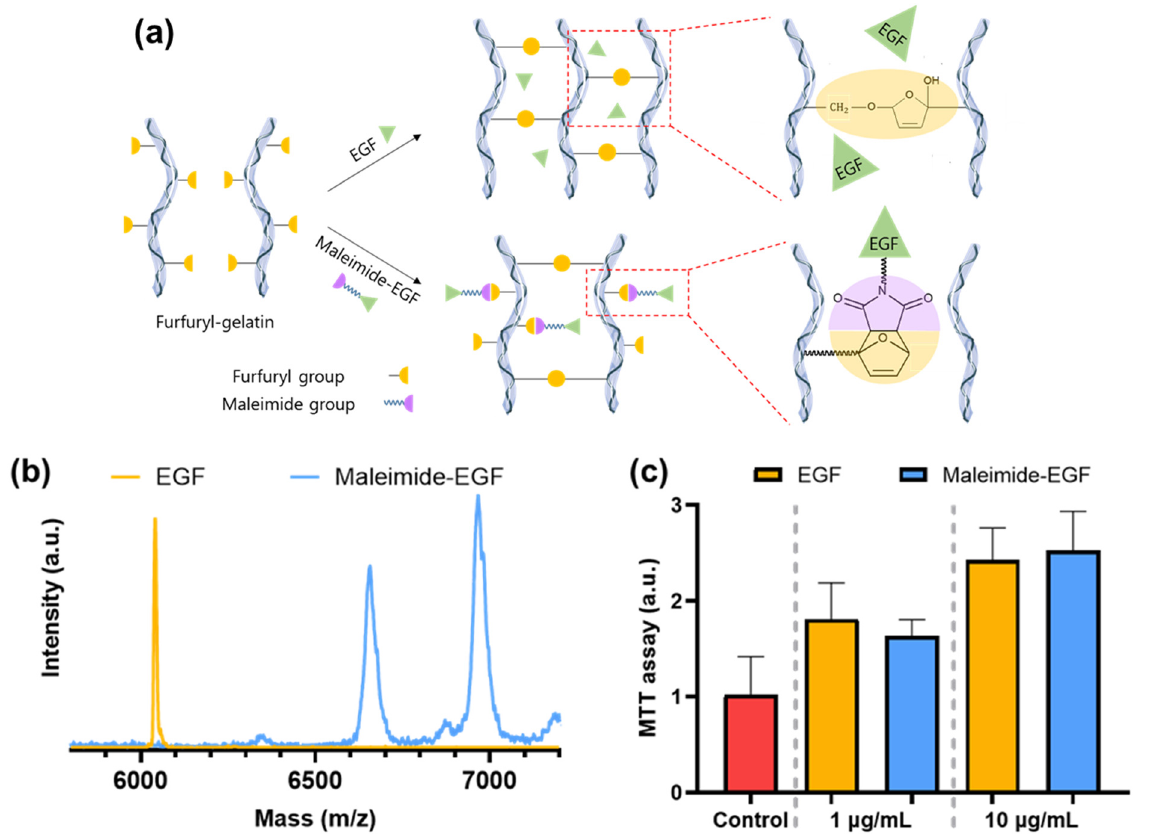
Figure 7. ( a ) Schematic representation of chemical coupling of maleimide-EGF with furfuryl-gelatin. ( b ) MALDI-TOF spectra of EGF and maleimide-EGF. ( c ) Cell proliferation due to EGF and maleimide-EGF.